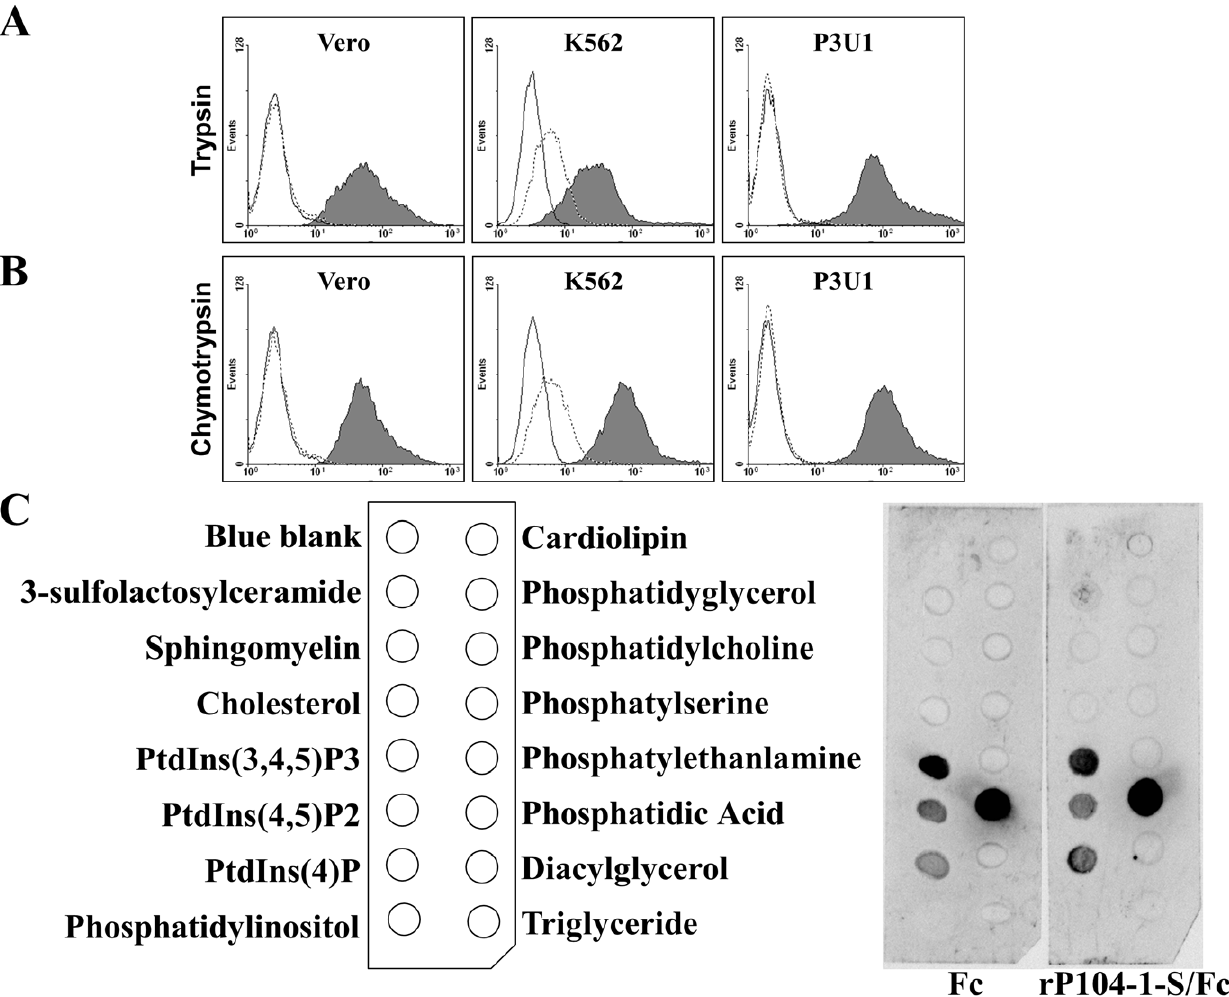
Figure 5. The attachment of rP104-1-S/Fc to host cells was not affected by protease digestion of cell surface proteins, and the receptor was not a major lipid on the cell surface. Vero, K562, and P3U1 cells were treated with trypsin (A) or chymotrypsin (B) to remove surface proteins, and then incubated with rP104-1-S/Fc (gray-filled histograms) or Fc (dotted line). The bound signals were detected by FACS analysis. The solid line indicates the cell-only control. C. rP104-1-S/Fc was incubated with a membrane spotted with 15 major lipids from the cell surface (right panel). The membrane was then immersed in HRP-conjugated anti-mouse antibodies, and reaction spots were revealed using the ECL system. Fc was used as a negative control (central panel). The names of lipids were shown on the left